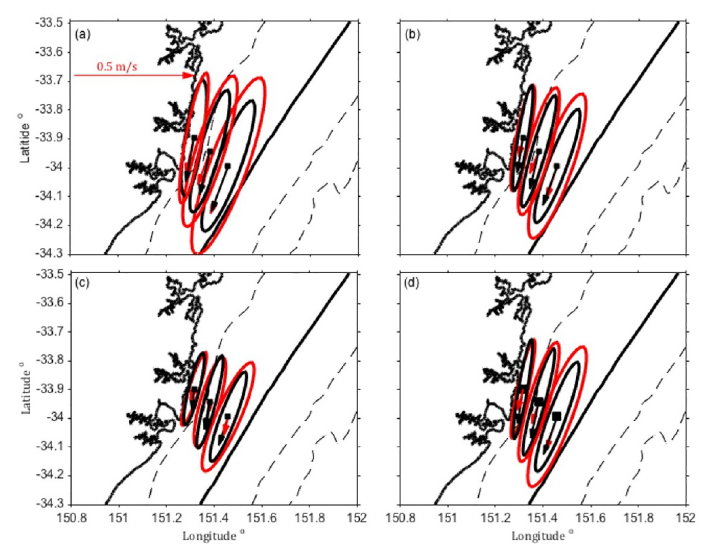
Fig 4. Mean current vectors and variance ellipses of modelled (HSM, black) and observed (red) velocities for 2012–2013 at the location of the 3 moorings off Sydney. Dashed lines show the 100, 1000 and 2000 m isobath; the solid black line shows the location of the 200 m isobath. (a) Upper—depth bin, (b) mid—depth bin, (c) bottom—depth bin and (d) full water column, depth averaged velocities in ms -1 .